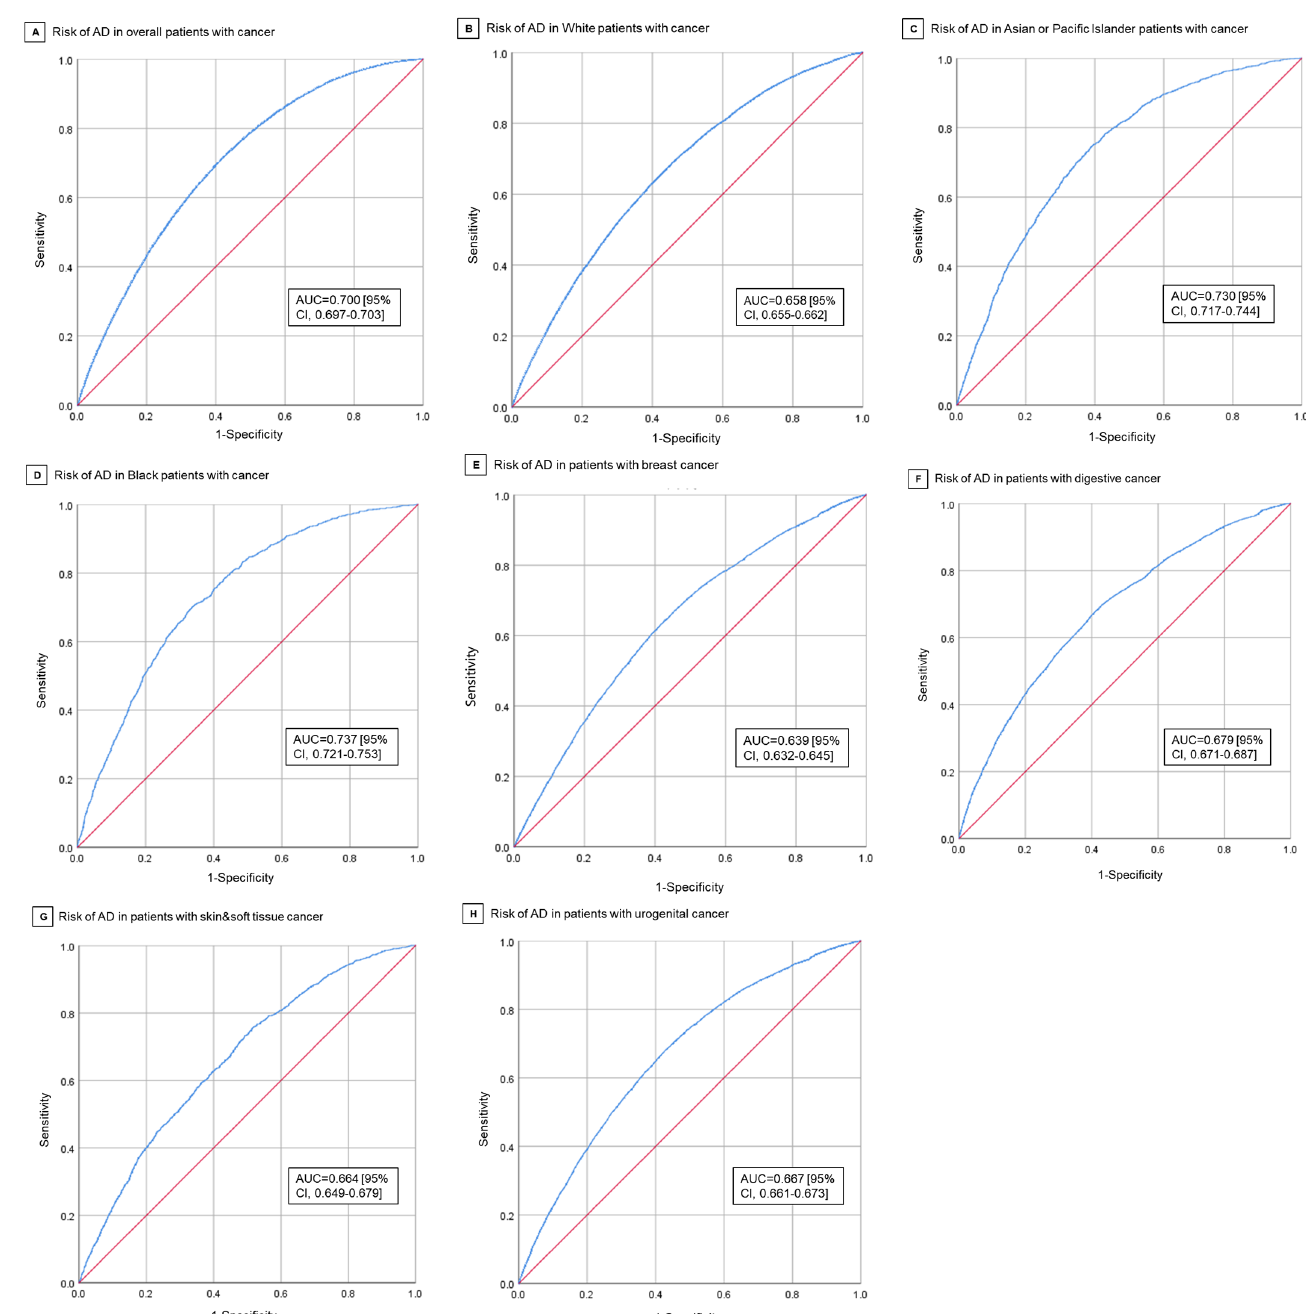
Figure 2. Receive-Operating Characteristics Curves for Risk of AD in Cancer Patients. (a) Risk of AD in overall cancer patients. (b) Risk of AD in White cancer patients. (c) Risk of AD in Asian/Pacific Islander cancer patients. (d) Risk of AD in Black cancer patients. (e) Risk of AD in breast cancer patients. (f) Risk of AD in digestive system cancer patients. (g) Risk of AD in skin and soft tissue cancer patients. (h) Risk of AD in urogenital cancer patients.